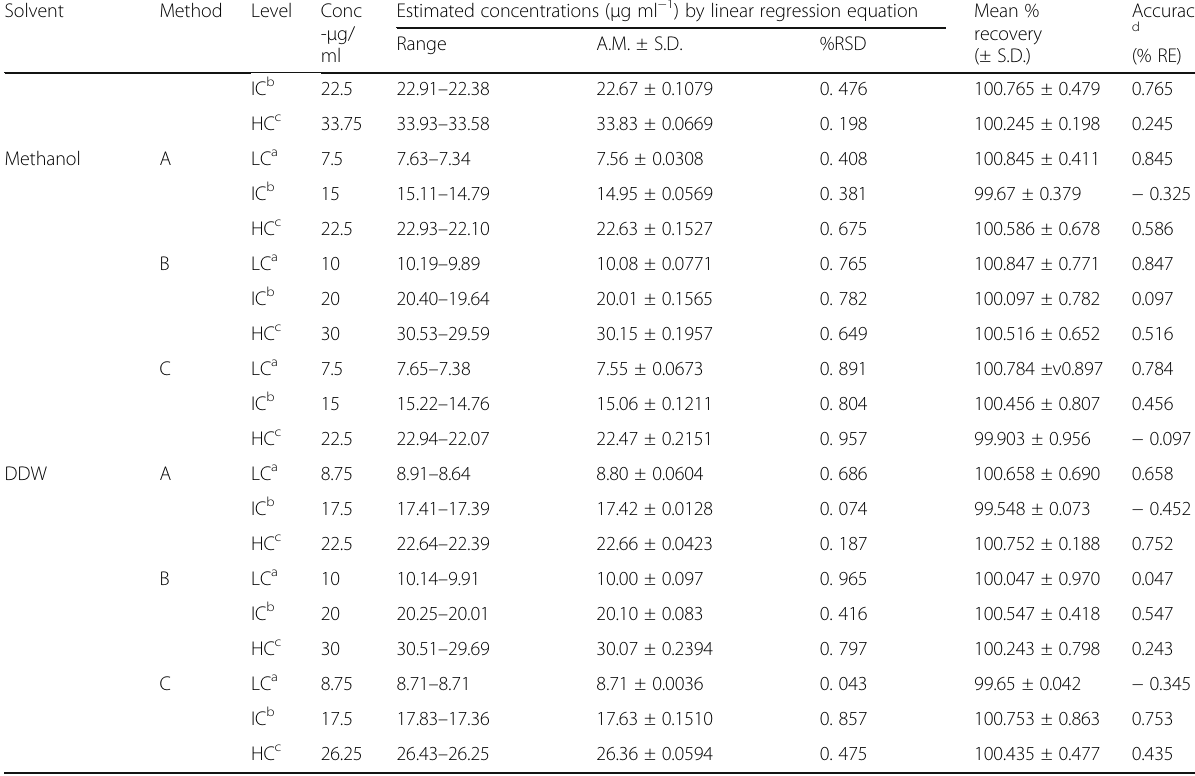
Table 3 Accuracy and precision analysis data